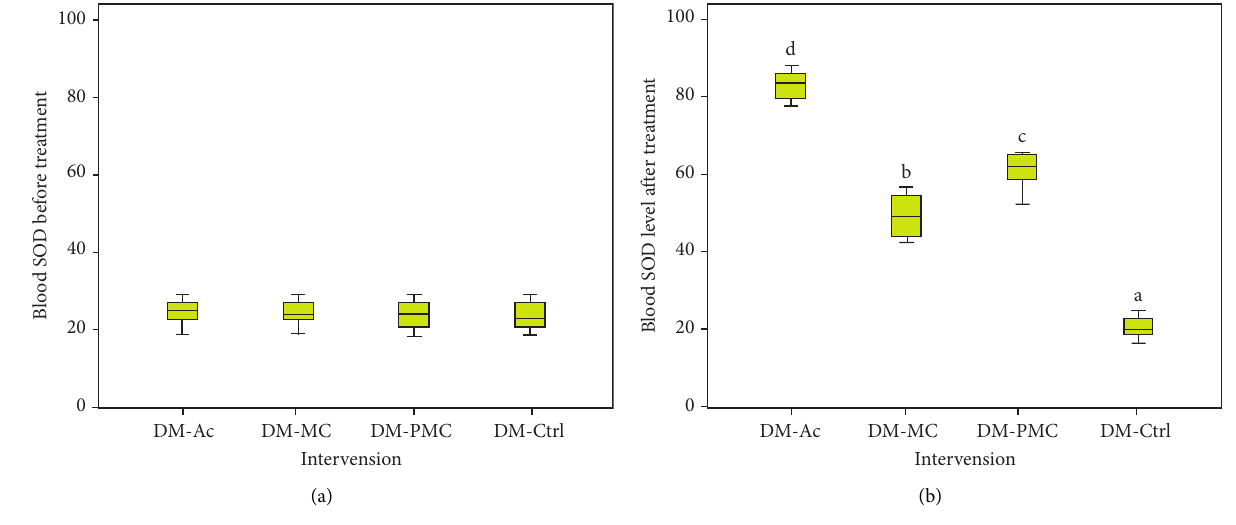
Figure 4: SOD level: (a) before treatment; (b) after